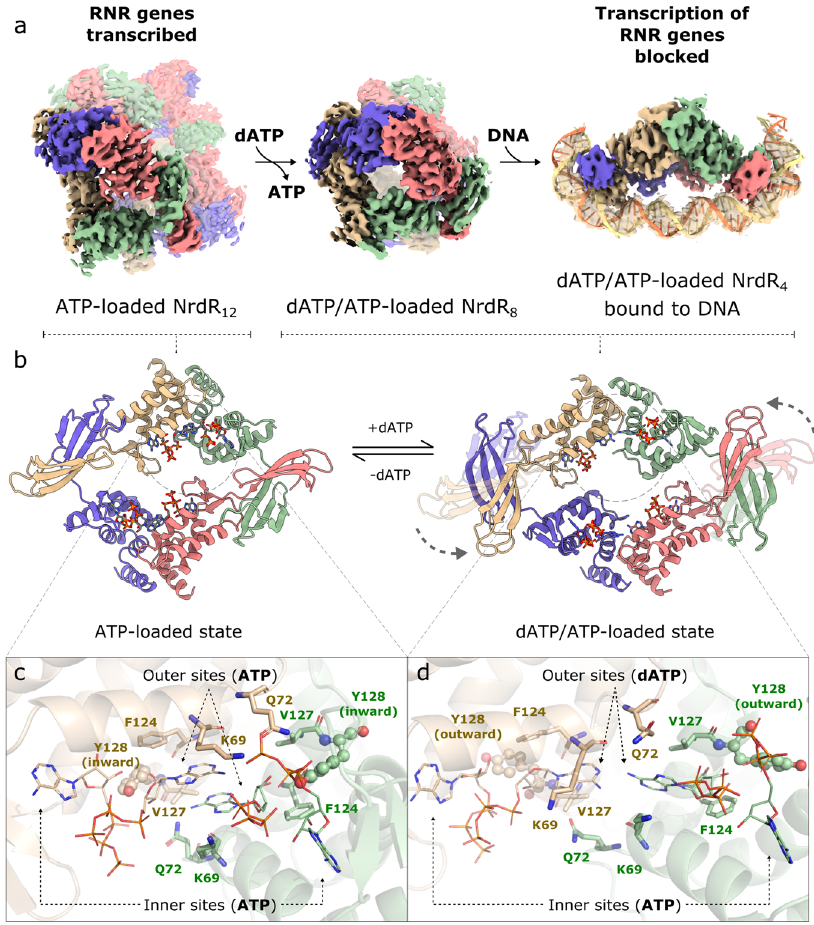
Fig. 2 Mechanism of NrdR function involving dodecameric, octameric, and tetrameric structures. a Surface representation of the cryo-EM maps for the dodecameric, octameric, and DNA-bound tetrameric NrdR structures. b Cartoon representation of the ATP-loaded NrdR tetramer (left) and the dATP/ ATP-loaded tetramer (right). Chains A, B, C, and D are colored in beige, green, pink, and blue, respectively. c Interface between the ATP-cones in chain A (beige) and chain B (green) in the ATP-loaded dodecamer and ( d ) in the dATP/ATP-loaded tetramer. Panels c , d were made from the same perspective, based on an alignment of the ATP-cones in chains A and B in both